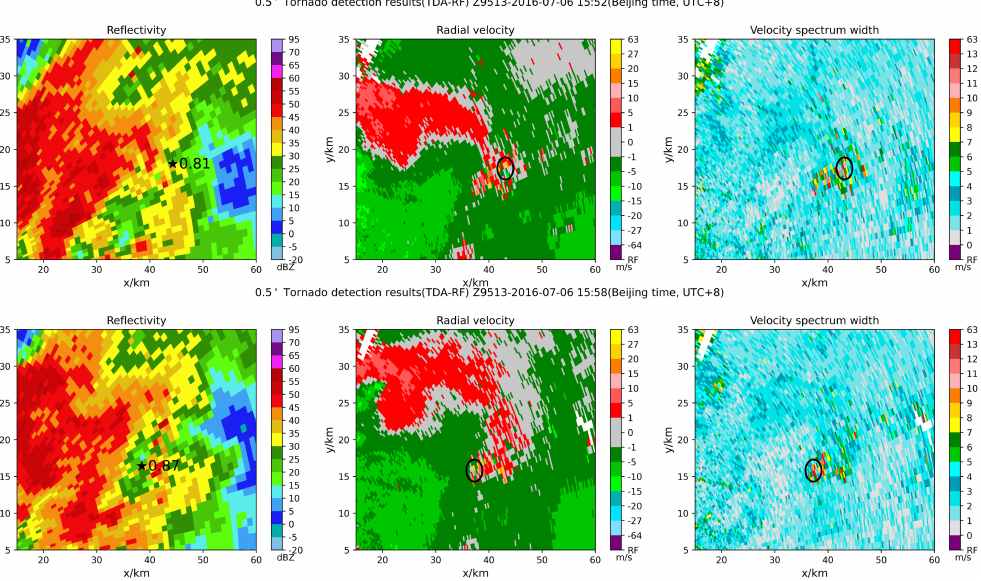
Figure 9. 0.5 ◦ tornado detection results (TDA-RF), Z9513-20160706-15:52 and 15:58 (UTC+8), the tornado was EF0. (asterisk corresponds to the identification center, and the value corresponds to the probability; the black circle has a radius of 1.5 km centered on the identification